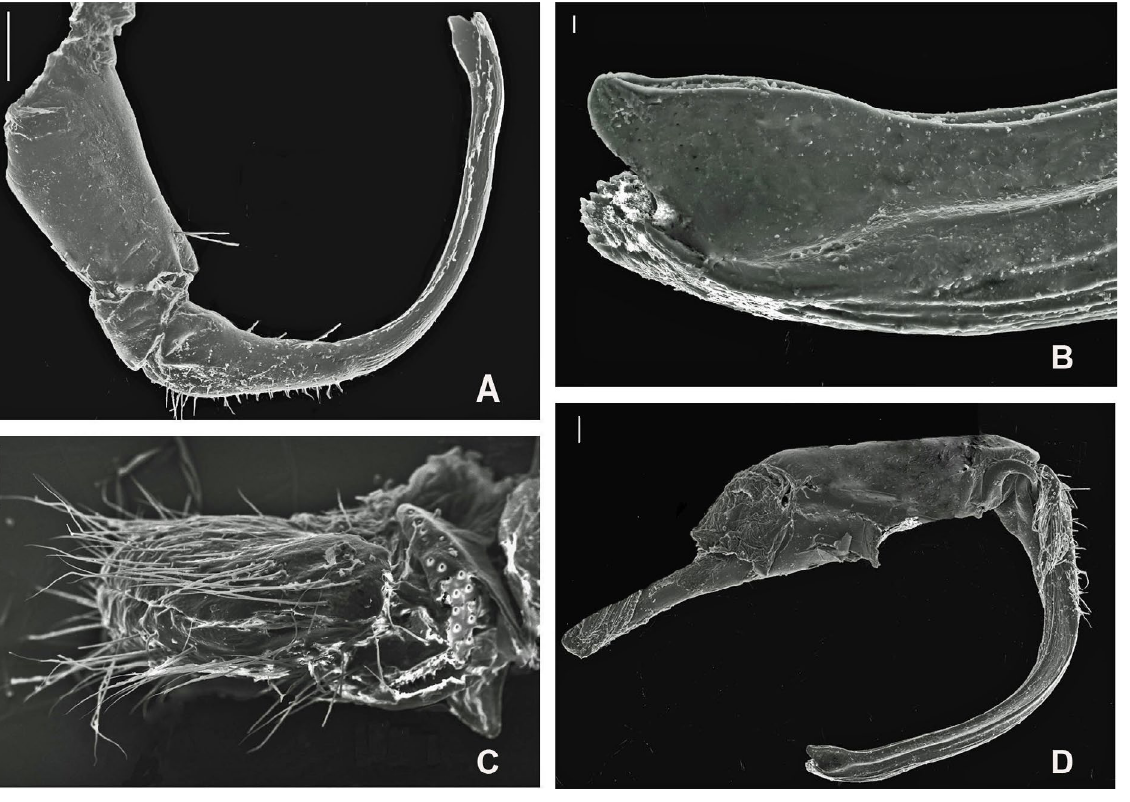
Fig. 6. Levizonus malewitschi Lokschina & Golovatch, 1977, ♂ (FSCB 11986) and ♀ (FSCB 11982). A . Gonopod, lateral view. B . Gonopod apex, mesal view. C . Vulva, mesal view. D . Gonopod, mesal view. Scale bars: A = 200 μm; C–D = 100 μm; B = 10